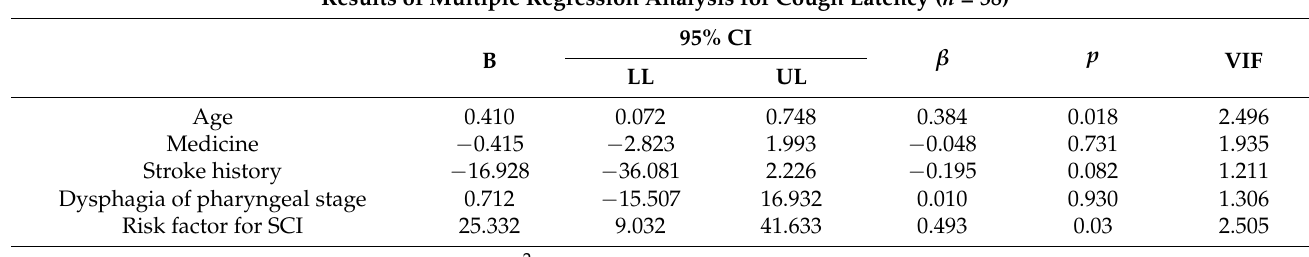
Table 3. Results of multiple regression